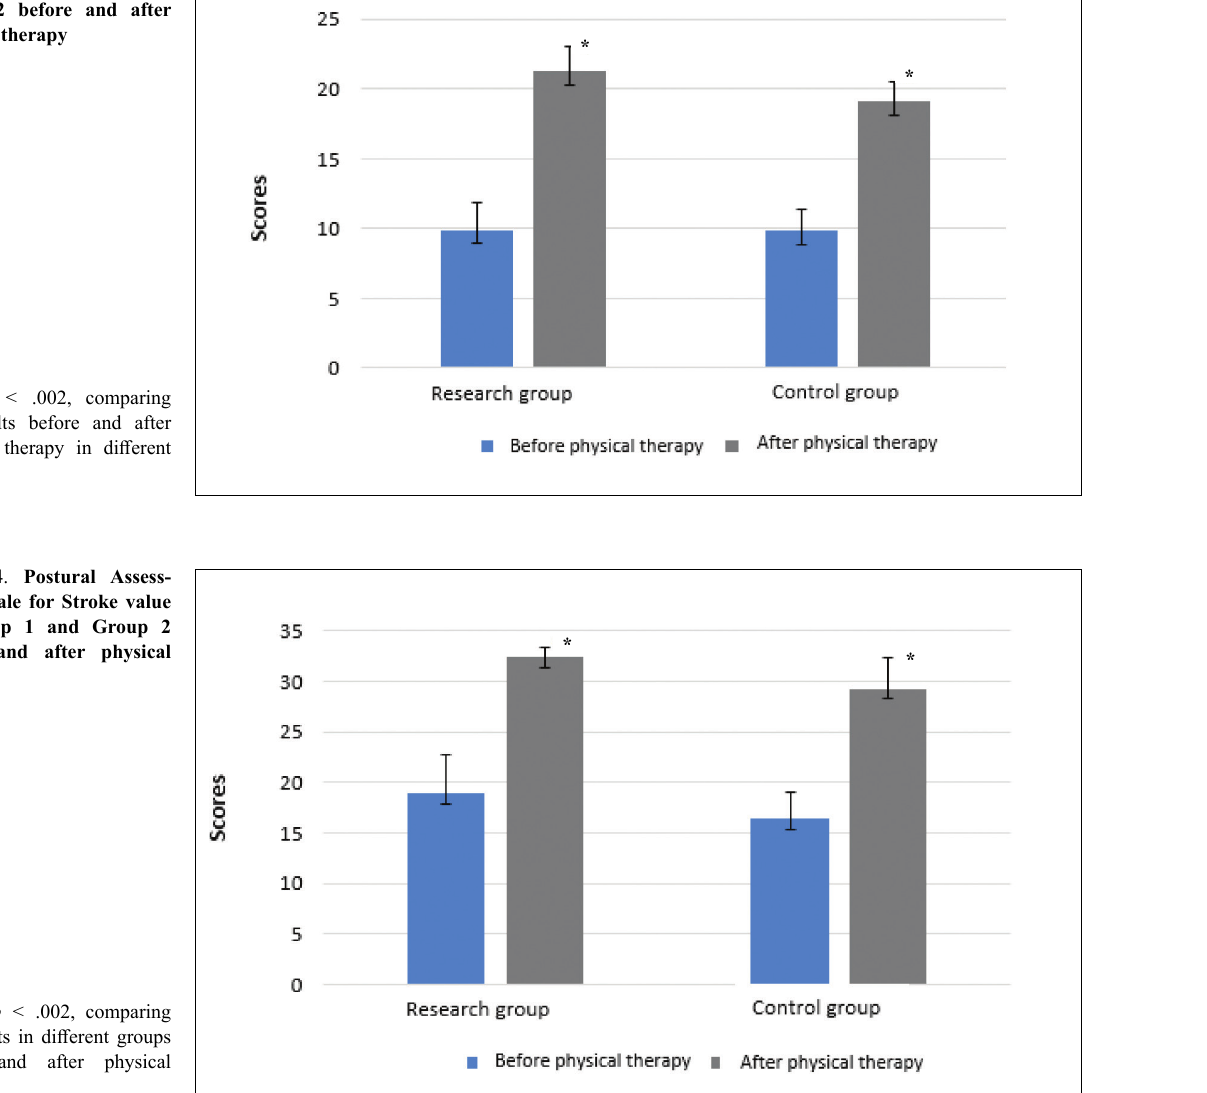
Figure 3. The Dynamic Gait Index value in Group 1 and Group 2 before and after